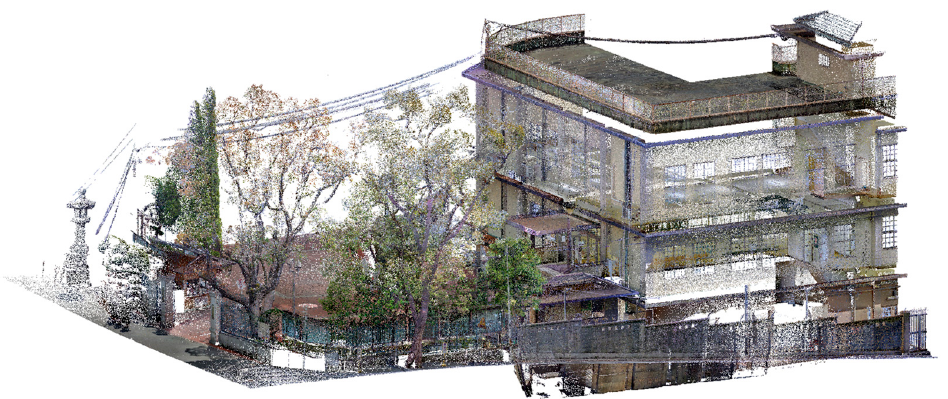
Figure 12. 3D laser-scanned data used in our comparative experiments of deep learning networks (10,480,242 points). The scanned target is the campus building of Kyoto Women’s University, Japan.